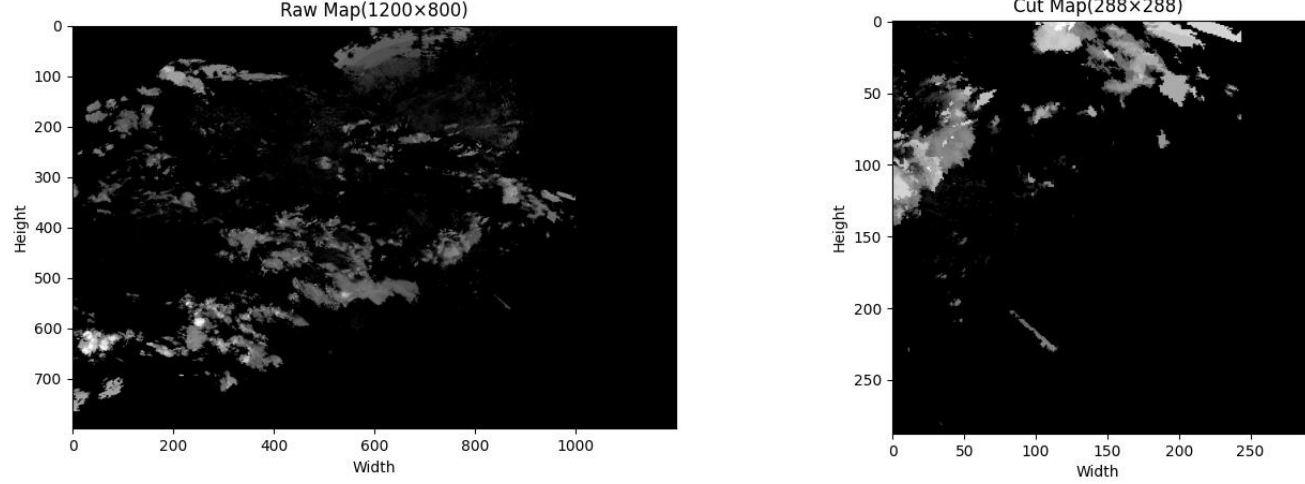
Figure 8. Weather radar data map.